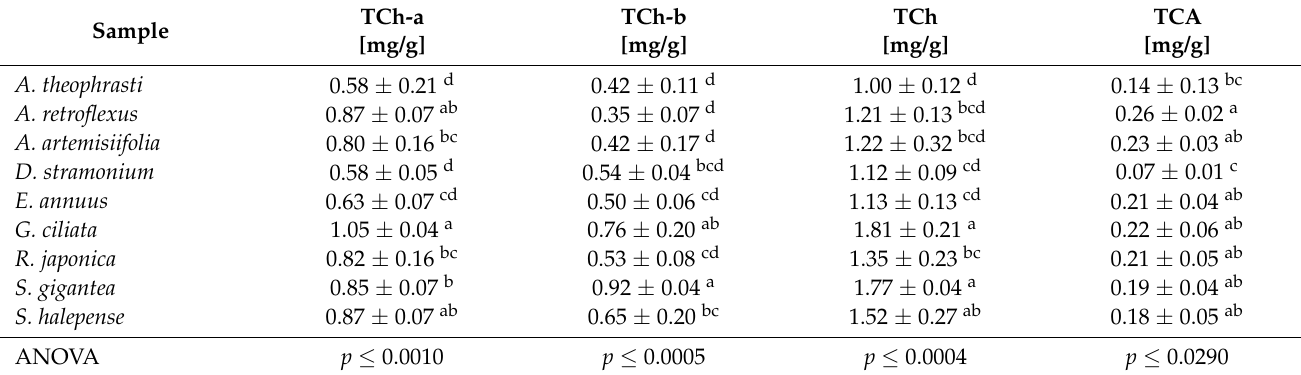
Values are presented as means of three determinations ± standard deviation. Values in the same column with the different superscript lowercase letters (a–d) indicate significant differences between means at p ≤ 0.0001; TCh-a—chlorophyll a; TCh-b—chlorophyll b; TCh—total chlorophyll content; TCA—total carotenoid